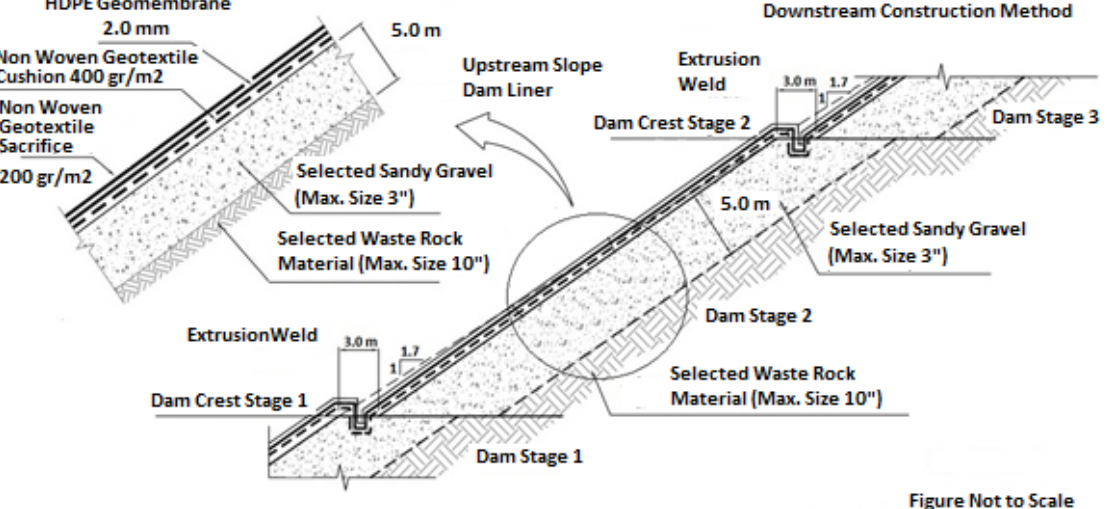
Figure 25. Mine waste rock (rockfill) dam upstream face waterproofing construction detail.